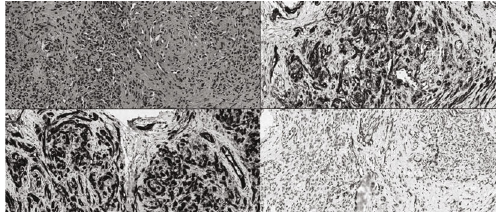
Figure 6: Pathologic slides of the tumor tissue obtained during the surgery ( × 40 high power fi elds). (a) HE staining. (b) Slide showing CD31 positive. (c) Showing CD34 positive. (d) Showing D2-40